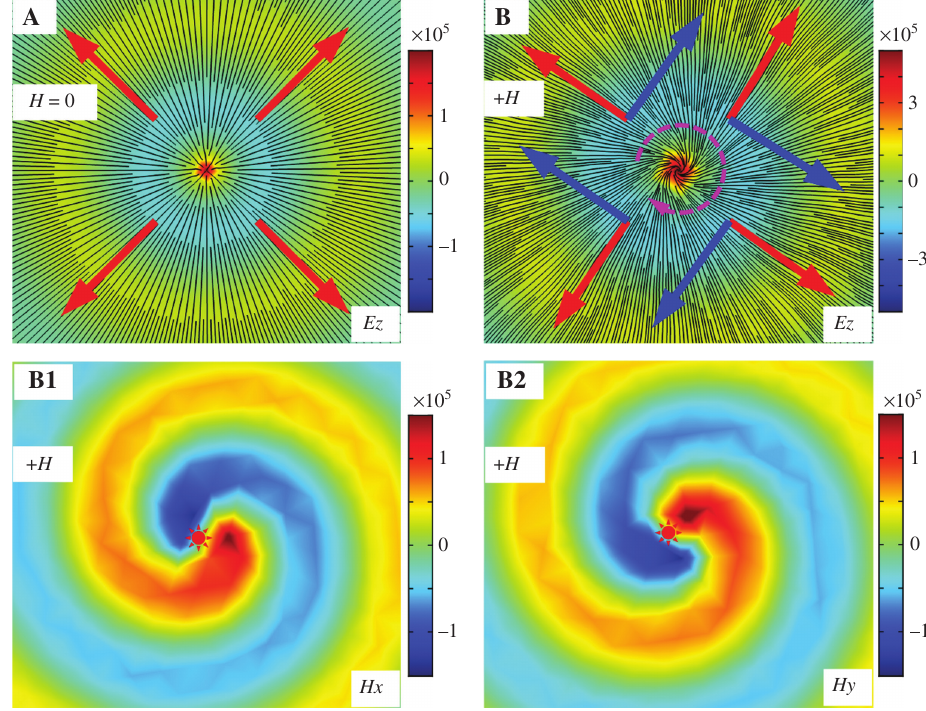
Figure 3: Numerical simulation results in an infinite uniform magneto-optical medium. (A) E -field for H = 0, (B) E -field for H = 1600 G ; the magenta dotted arrow represents the vortex direction of electromagnetic waves. (B1, B2) z z H - and H -field corresponding to (B). In all these cases the point source denoted by red shining stars radiates at f (cid:31) (cid:31) x y blue arrows represent S and S , r i